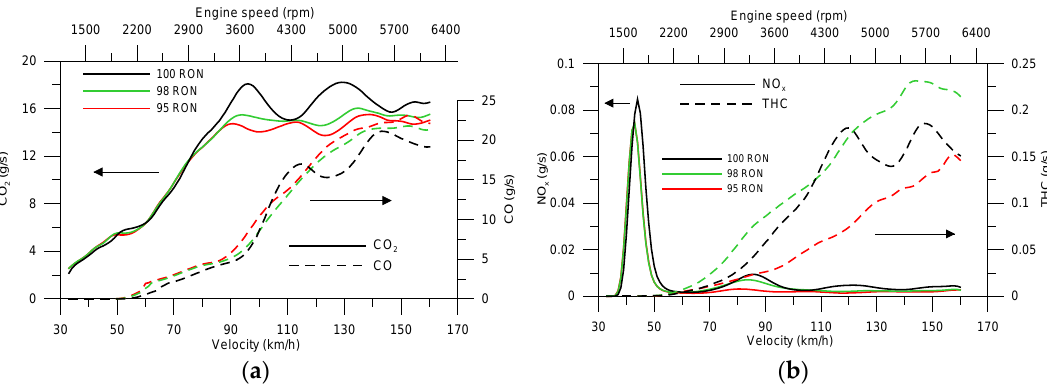
Figure 8. CO 2 and CO emissions ( a ) and NO x and total hydrocarbon (THC) emissions ( b ) along Figure8. CO 2 andCOemissions( a )andNO x andtotalhydrocarbon(THC)emissions( b toothsaw.